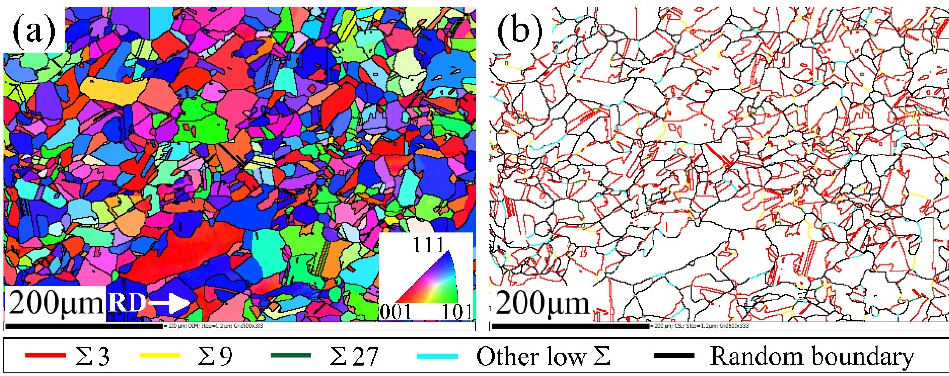
Figure 2. The ( a ) orientation imaging microscopy and ( b ) GBCD of the solution annealed sample with a diameter of 2 mm.